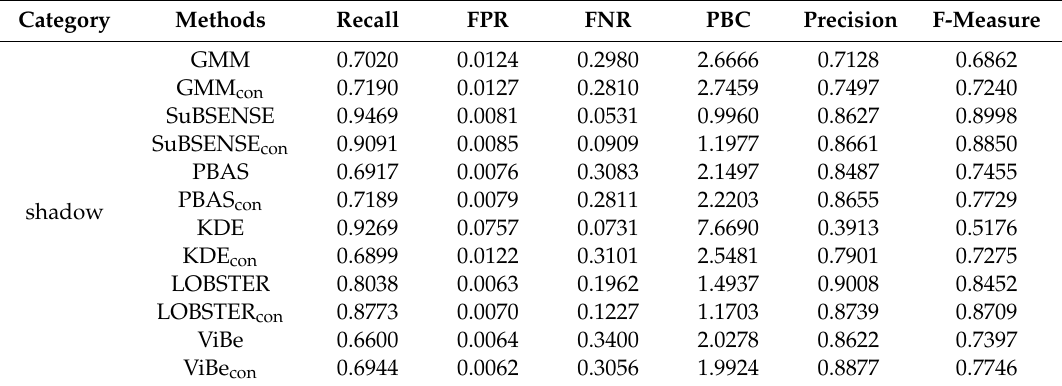
Figure 6. Refinements of the background-subtraction methods on shadow videos. Table 7. Comparisons between BGS and BGS con by the proposed method.